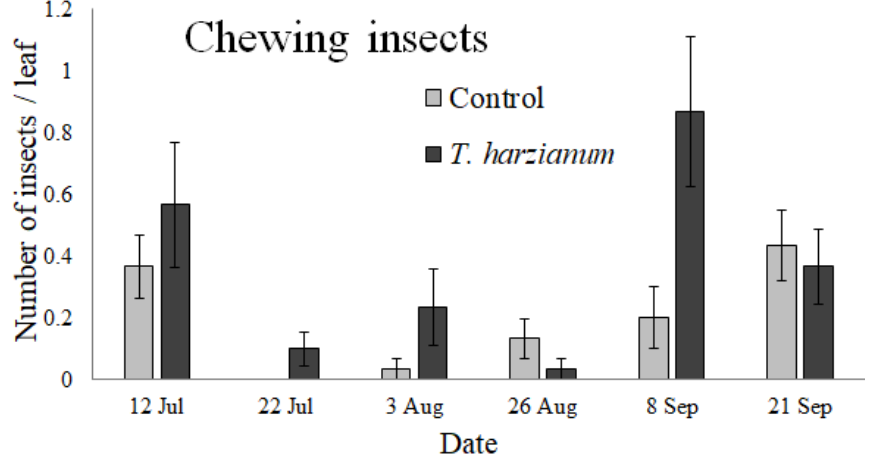
Figure 5. Mean values (± standard errors) of insect abundance in the chewing group collected on tomato leaves during the experiment.